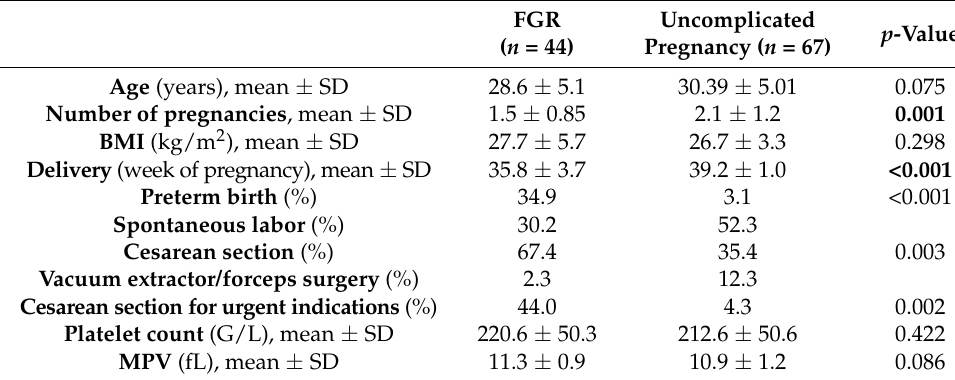
Table 1. Demographic characteristics of the studied group of pregnant women ( n = 111), types of delivery, and general platelet parameters.